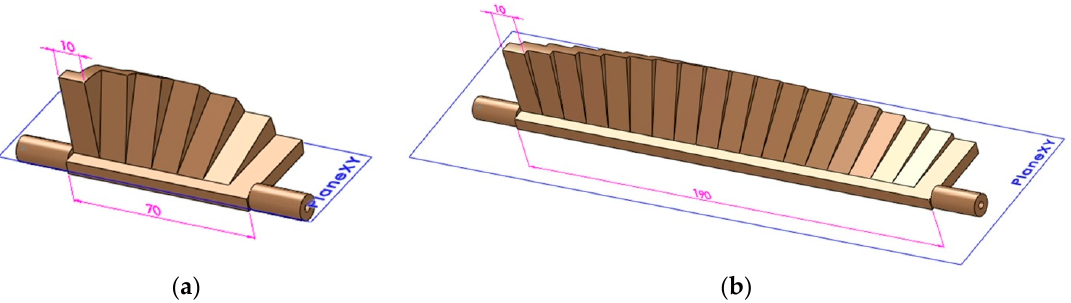
Figure 2. Three-dimensional (3D) models of the new test artifact: ( a ) artifact configuration 3; ( b ) artifact configuration 6.